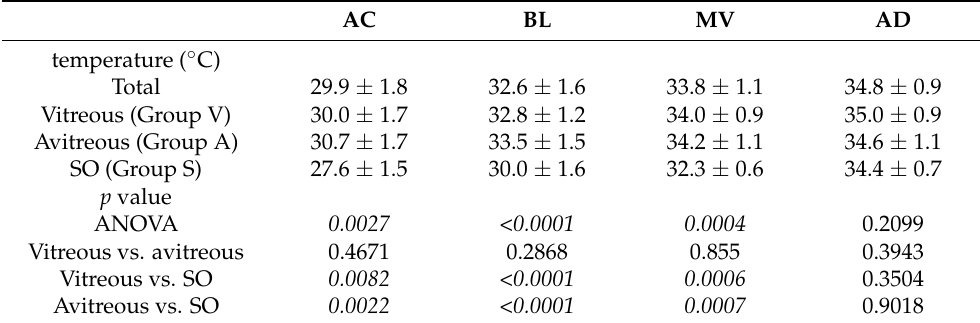
Figure 3. Distribution of the intraocular temperature at the beginning of vitrectomy in each group. Table 3. Intraocular temperature in each